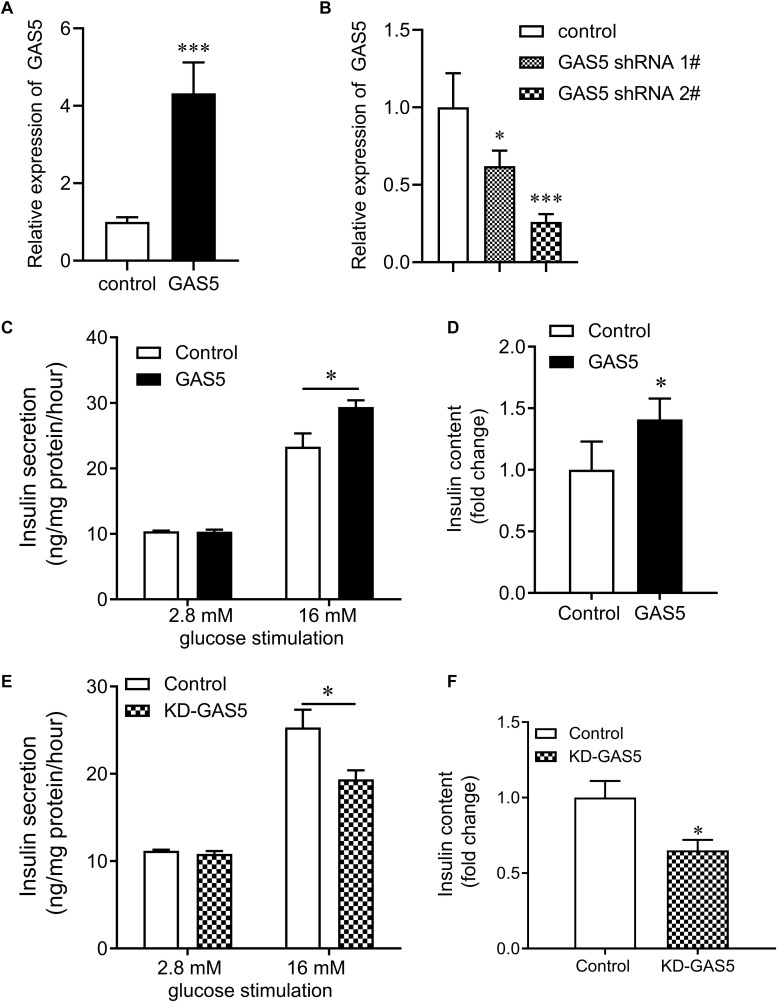
Effects of GAS5 on glucose stimulated insulin secretion in NS-1 832/13 cells. (A) QPCR was performed to determine the expression of GAS5 in INS-1 832/13 cells after transfection with lentivirus carrying GAS5 DNA sequence or empty pReceiver-Lv218 vector control. (B) QPCR was performed to determine the expression of GAS5 in INS-1 832/13 cells after transfection with lentivirus carrying GAS5 shRNA sequence or scramble control. (C) Insulin secretion in GAS5 overexpressed INS-1 832/13 cells after 2.8 mM or 16 mM glucose stimulation. (D) Insulin content in INS-1 832/13 cells after GAS5 overexpression. (E) Insulin secretion in GAS5 knocked down INS-1 832/13 cells after 2.8 or 16 mM glucose stimulation. (F) Insulin content in INS-1 832/13 cells after GAS5 knockdown. KD, knockdown. *p < 0.05.